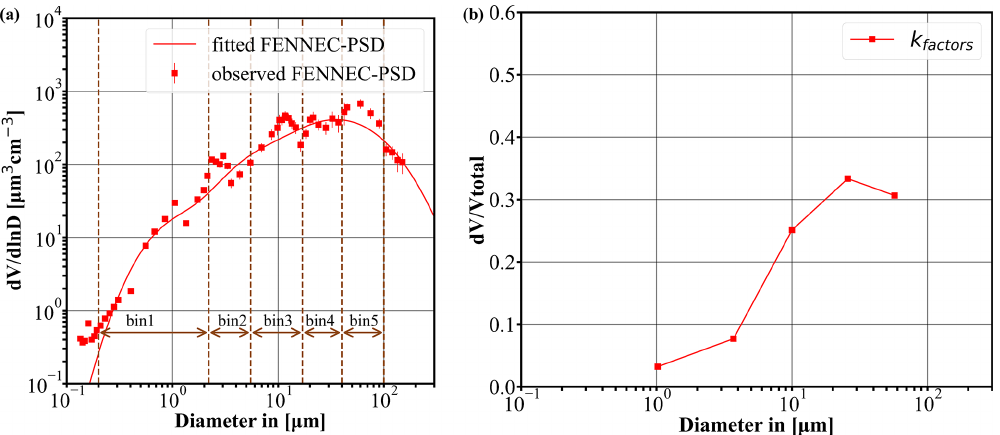
Figure 2. Prescribed dust size distribution used in the WRF-L for the distribution of total dust mass to the transport model size bins: (a) “observed FENNEC-PSD” (µm 3 cm − 3 ) (red squares) and the respective “fitted FENNEC-PSD” (red solid line). The “observed FENNEC- PSD” corresponds to the PSD observations at 1km, obtained by averaging profile-measured data of freshly uplifted dust cases over 500m. The arrows indicate the model transport size bins in WRF-L. Error bars indicate the standard deviations of the observed values. (b) The k factors of the transport size bins calculated based on “fitted FENNEC-PSD” provide the mass fraction of the emitted dust for each bin.